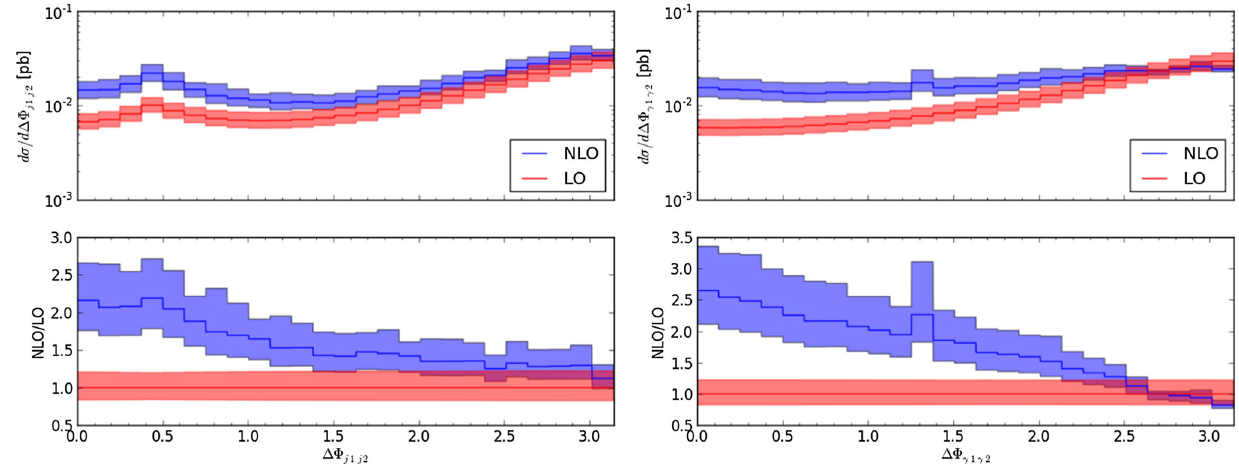
Fig. 6 Azimuthal separation of the two leading jets (l.h.s.) and the two photons (r.h.s.)